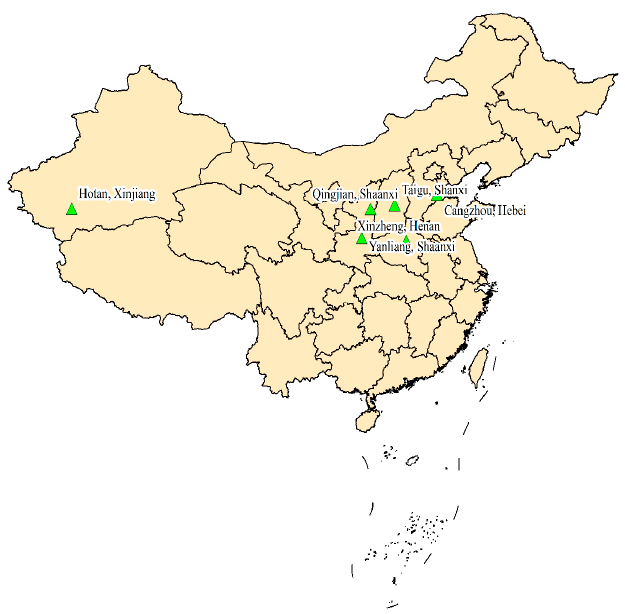
Figure 1. Sampling sites of Chinese jujube